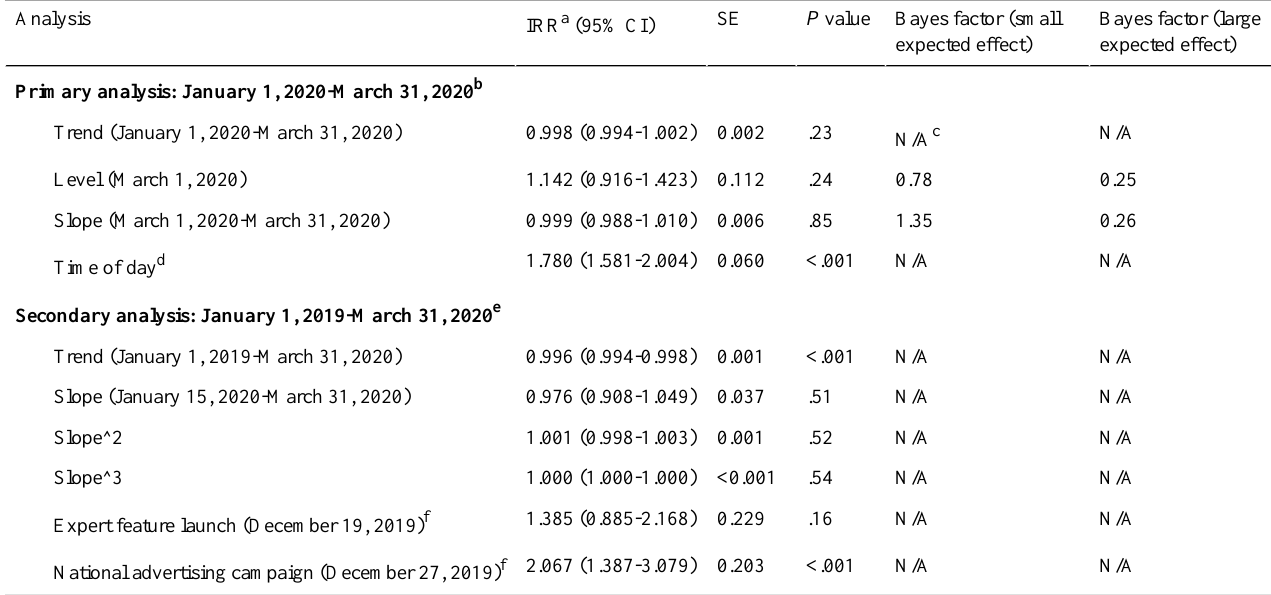
Table 2. Results from the best fitting model for each analysis.